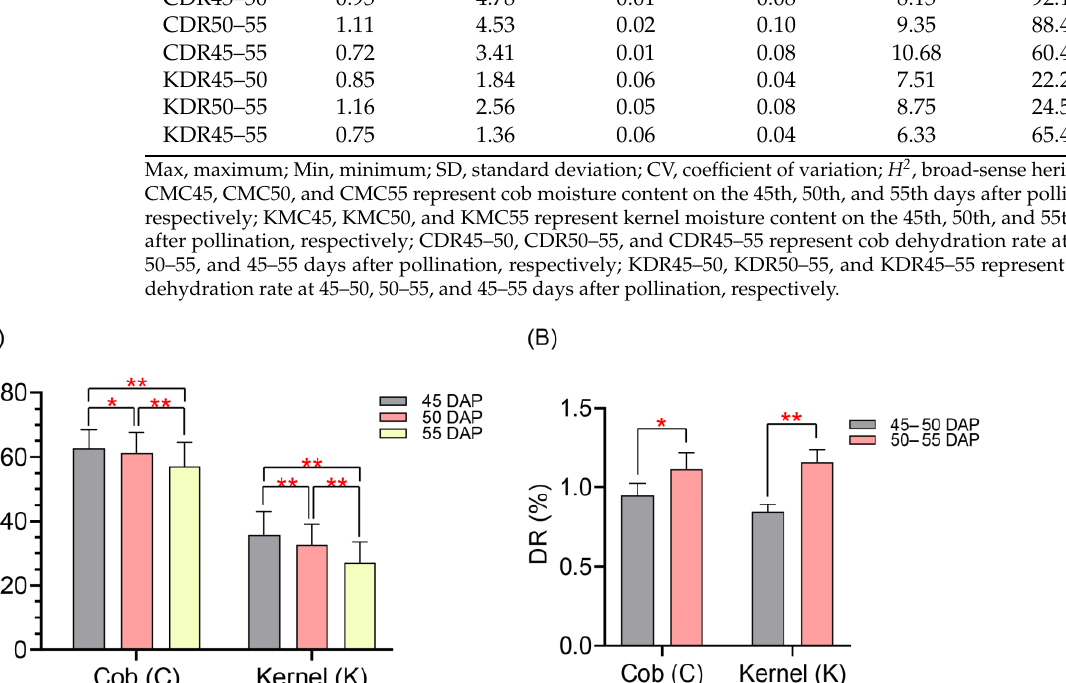
Table 1. Cont. Trait Mean (%) Max (%) Min (%) SD CV (%) H 2 (%)